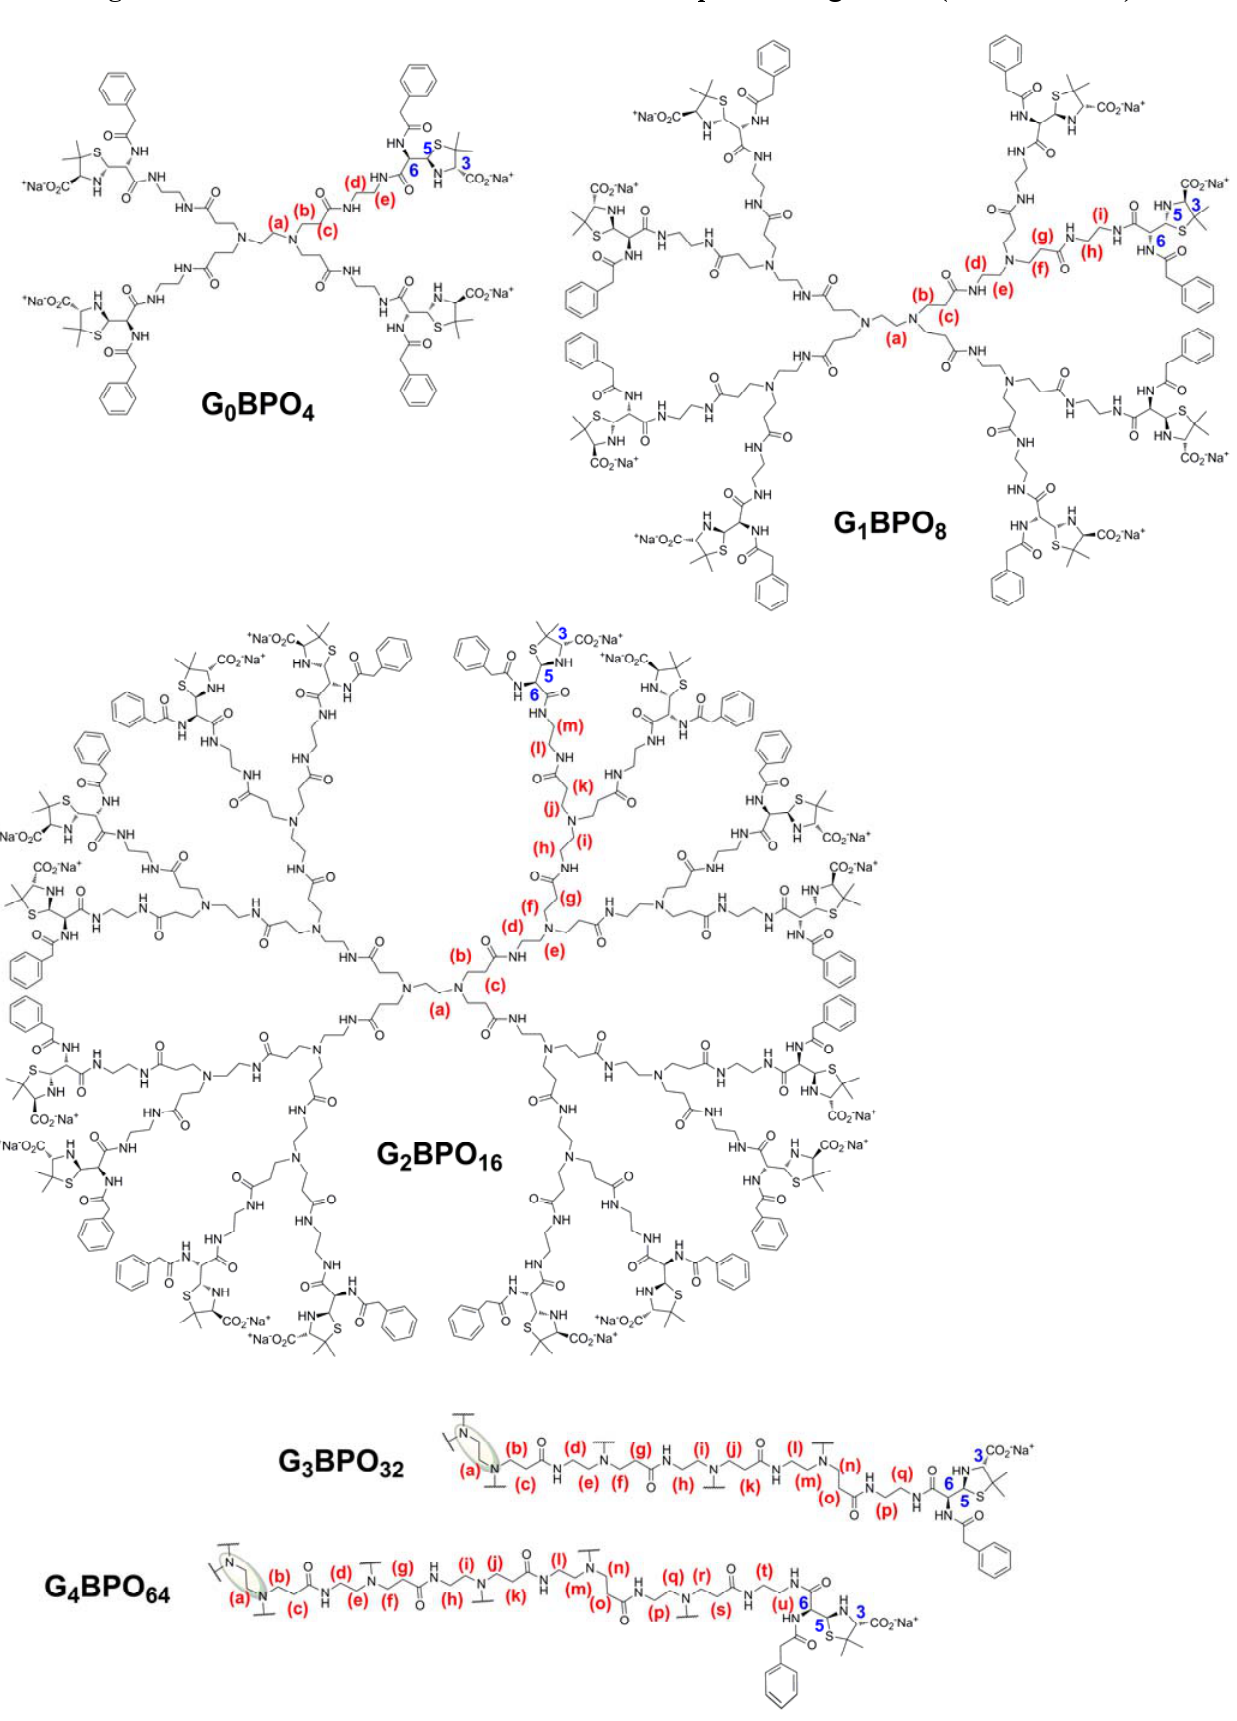
Figure 3. G BPO structures with color labeled for proton assignments (Tables 3 and n